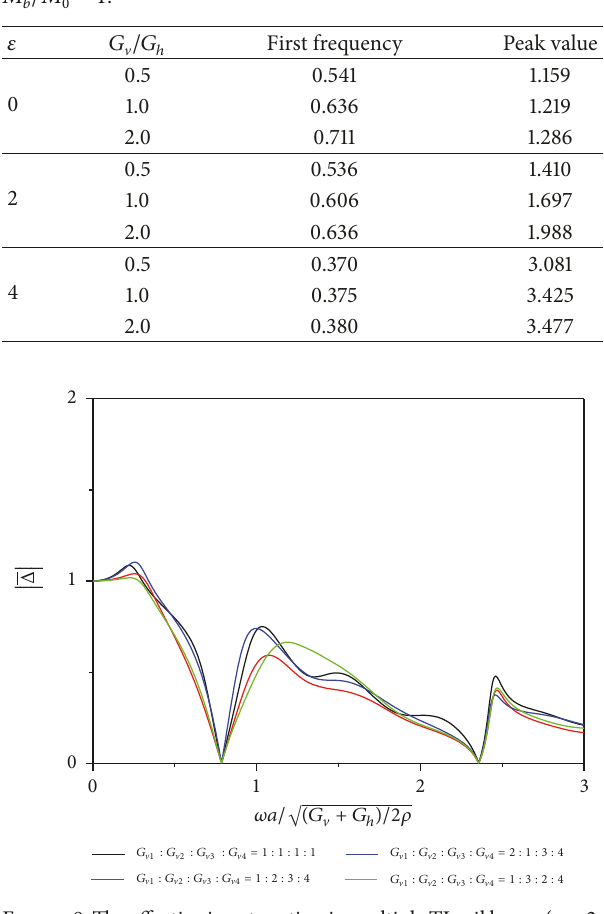
Figure 8: The effective input motion in multiple TI soil layers ( 𝜀 = 2 , 𝑀 /𝑀 = 1 ). 𝑏 0